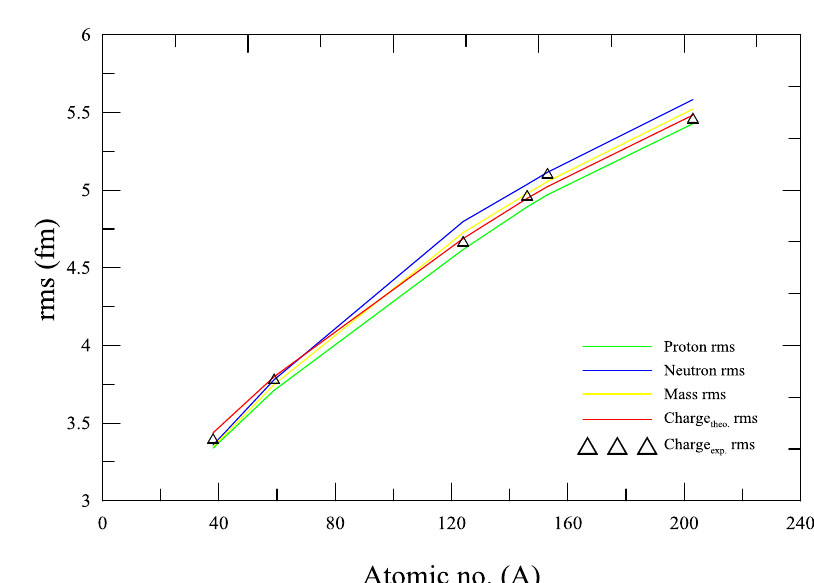
Fig.2: Rms for selected target nuclei calculated using SkM* Skyrme parameterization along with experimental data taken from Ref